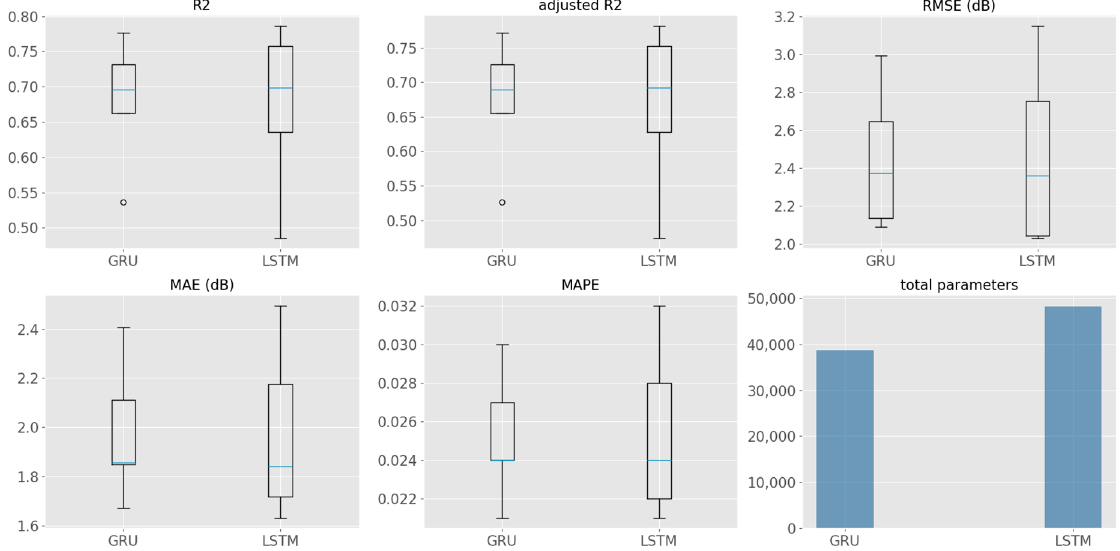
Figure 17. GRU and LSTM performance comparison, described by prediction accuracy indicators (boxplots) and computation cost indicator (bar plot).